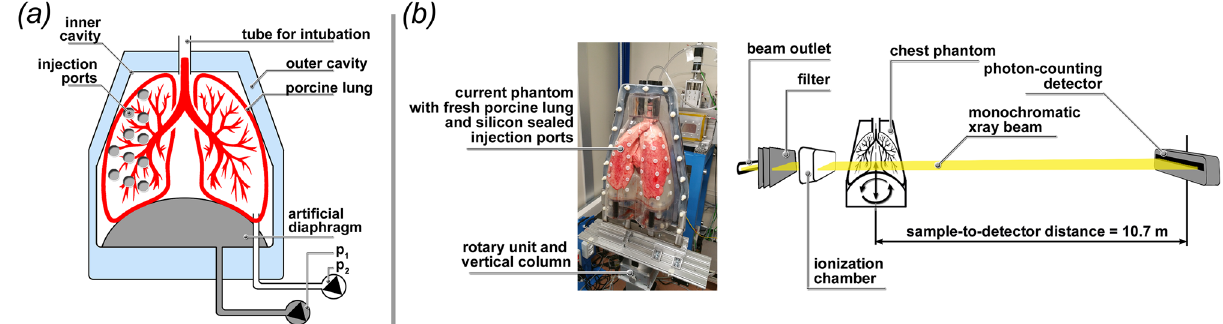
Figure 1. Experimental setup. ( a ) Schematic setup of the human chest phantom. The fresh pig lung is placed in the inner cavity above the artificial diaphragm and attached with the trachea to a tube for external access. One pump ( P 1 ) is used to maintain a negative pressure between inner cavity and lung resulting in the inflation of the lung. A second pump ( P 2 ) can be used to move the diaphragm, for which different breathing pattern can be programmed. Different outer covers exist that for instance allow to fill the outer cavity with water to mimic the x-ray absorption of the chest. Here we used a single cover with sealed injection ports that allowed injection of artificial tumor nodules in the lung. (b) Shows the phantom mounted up-right on top of the rotary unit in front of the beam outlet and the ionization chamber. The photon counting detector was mounted 10.7 m upstream to provide sufficient sample-to-detector distance to successfully exploit PBI.